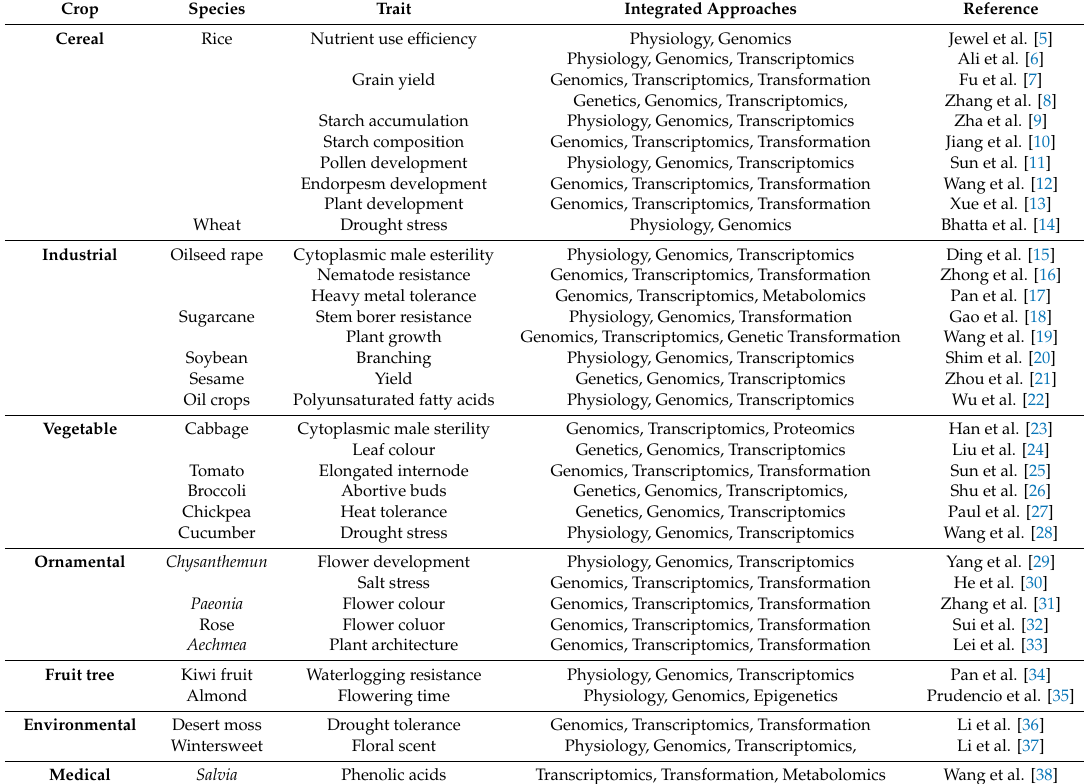
Table 1. Contributors to the Special Issue “Plant Genetics and Molecular